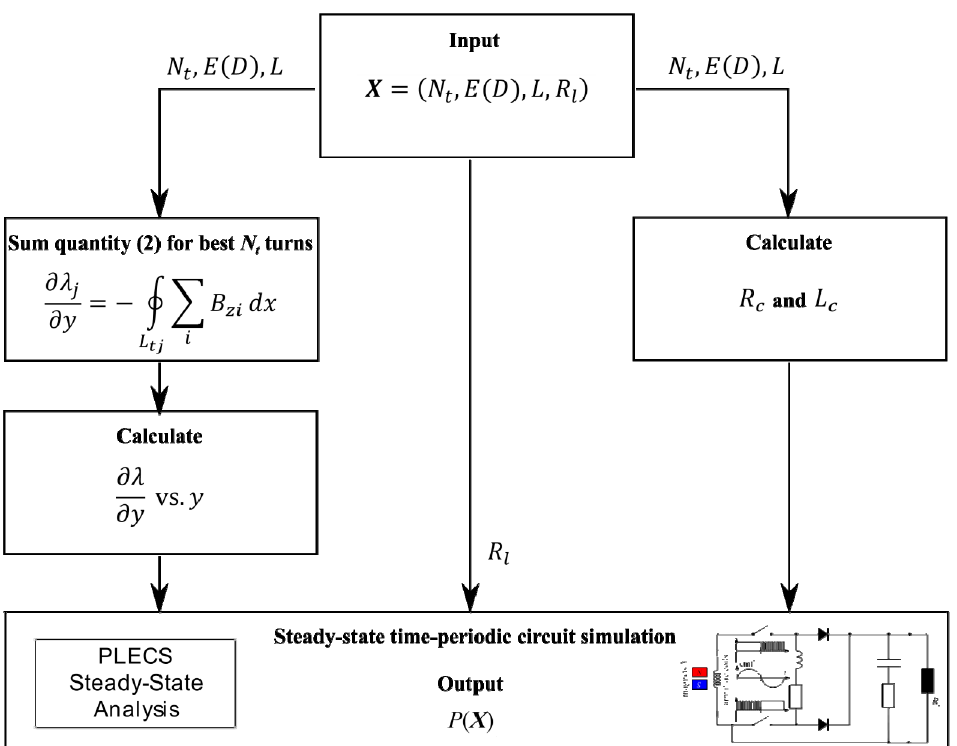
Figure 3. Diagram of computer model.